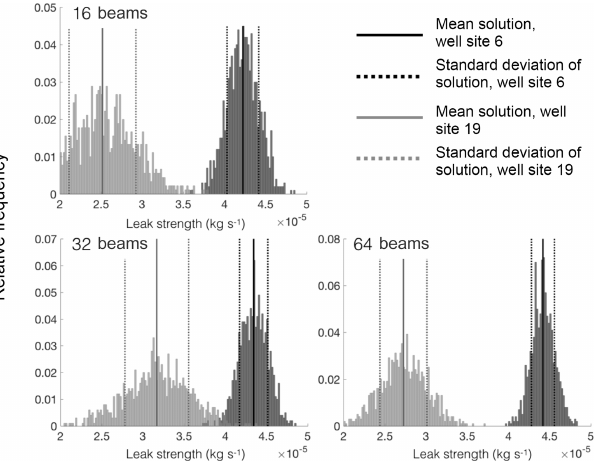
Figure 8. Histograms of source strength, with mean ± 1 standard deviation shown with vertical lines for well site 6 (black) and well site 19 (gray), for 16, 32, and 64 beam configurations, and with 10ppb model–data mismatch